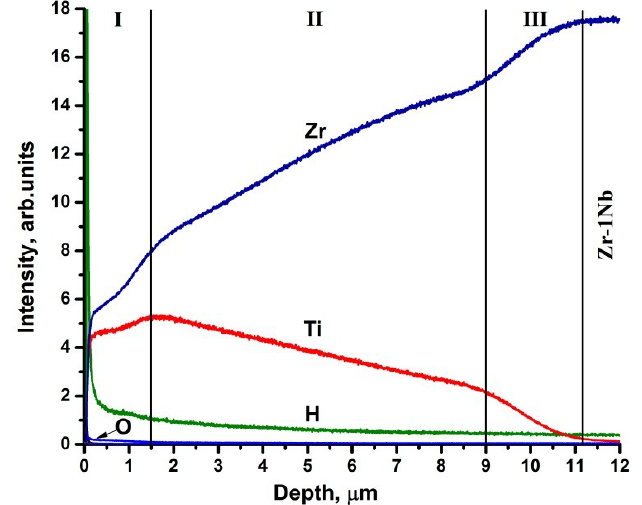
Figure 4. Glow-discharge optical emission spectroscopy (GDOES) profiles of elements in Ti-implanted alloy hydrogenated at 500 °C.